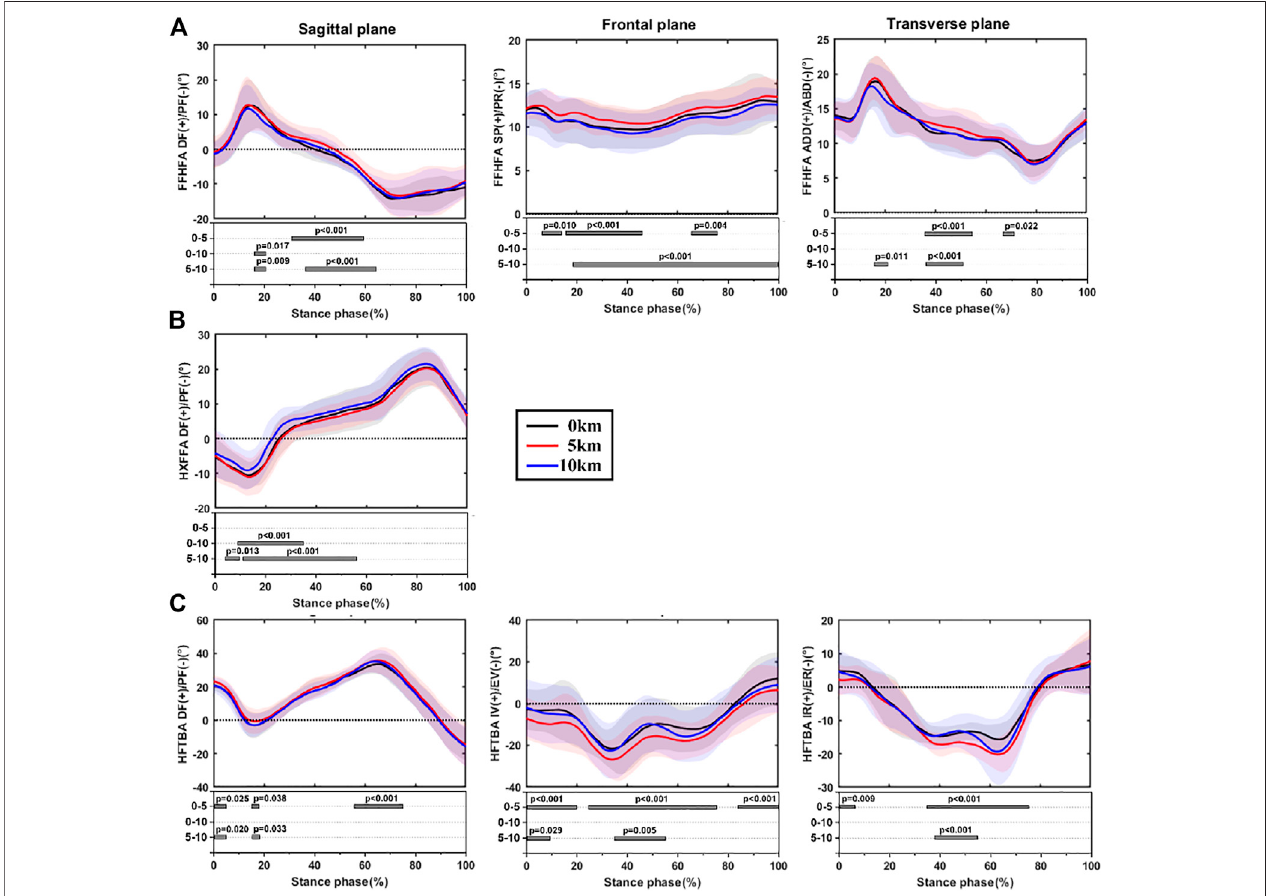
FIGURE 2 | The time-series data and SPM1d analysis of foot inter-segment kinematics during stance phase at baseline condition and immediately after 5 and 10 kmofrunning, (A) :forefootwithrespecttohindfootmotion; (B) :halluxwithrespecttoforefootmotion; (C) :hindfootwithrespecttotibiamotion.Note:FFHFA,forefoot with respect to hindfoot angles; HXFFA, hallux with respect to forefoot angle; HFTBA, hindfoot with respect to tibia angles; DF, dorsi fl exion; PF, plantar fl exion; SP, supination; PR, pronation; ADD, adduction; ABD, abduction; IV, inversion; EV, eversion; IR, internal rotation; ER, external rotation.